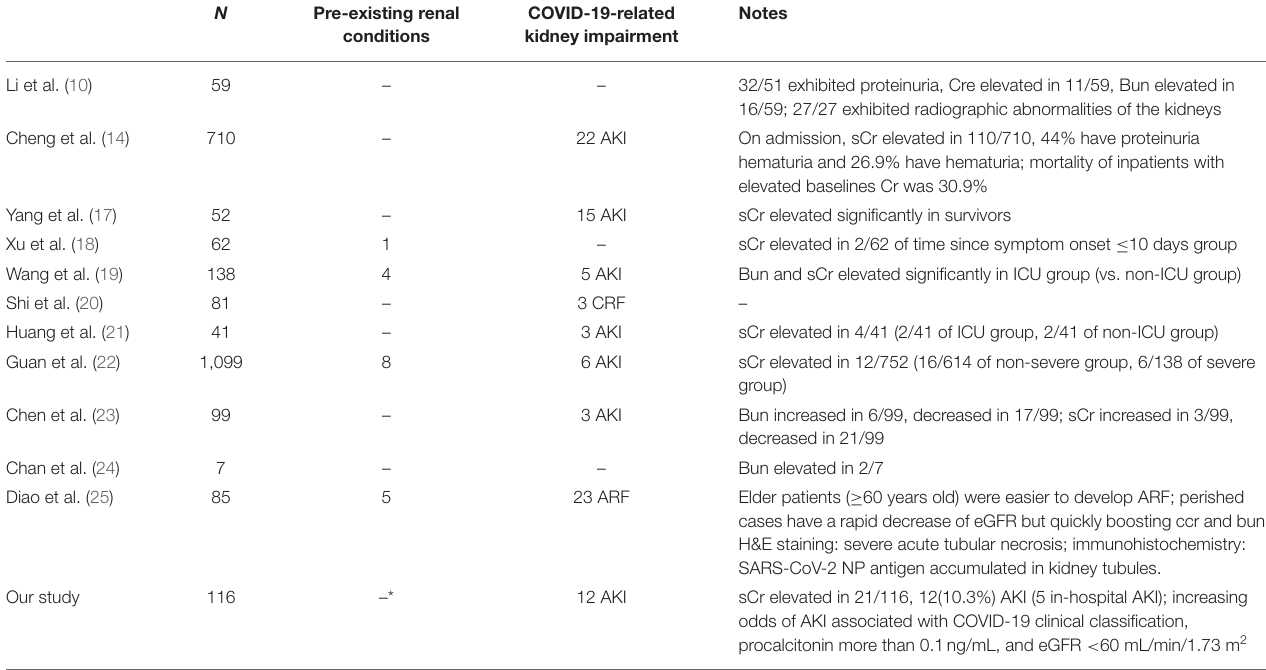
TABLE 5 | Review of the COVID-19 related kidney